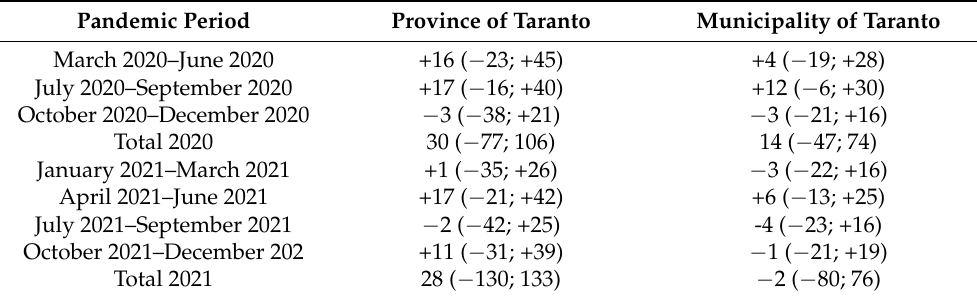
Table 4. Estimated excess lung cancer deaths during the pandemic and their 95% confidence intervals in the province and the municipality of